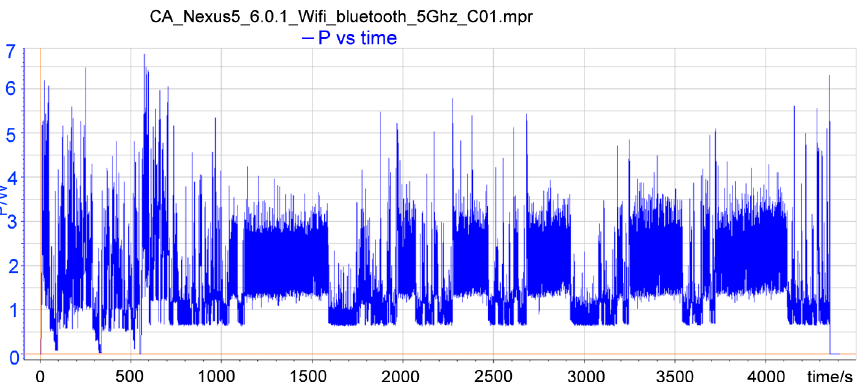
Figure 4. Plot of the energy consumption required for a file transfer from a smartphone LG Nexus 5 by means of the concurrent usage of interfaces WiFI and